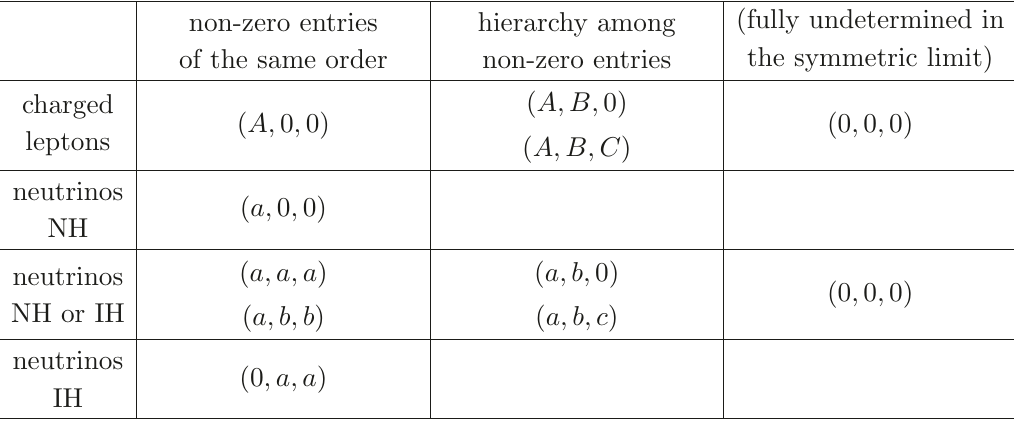
Table 1 . Charged lepton and neutrino mass patterns in the symmetric